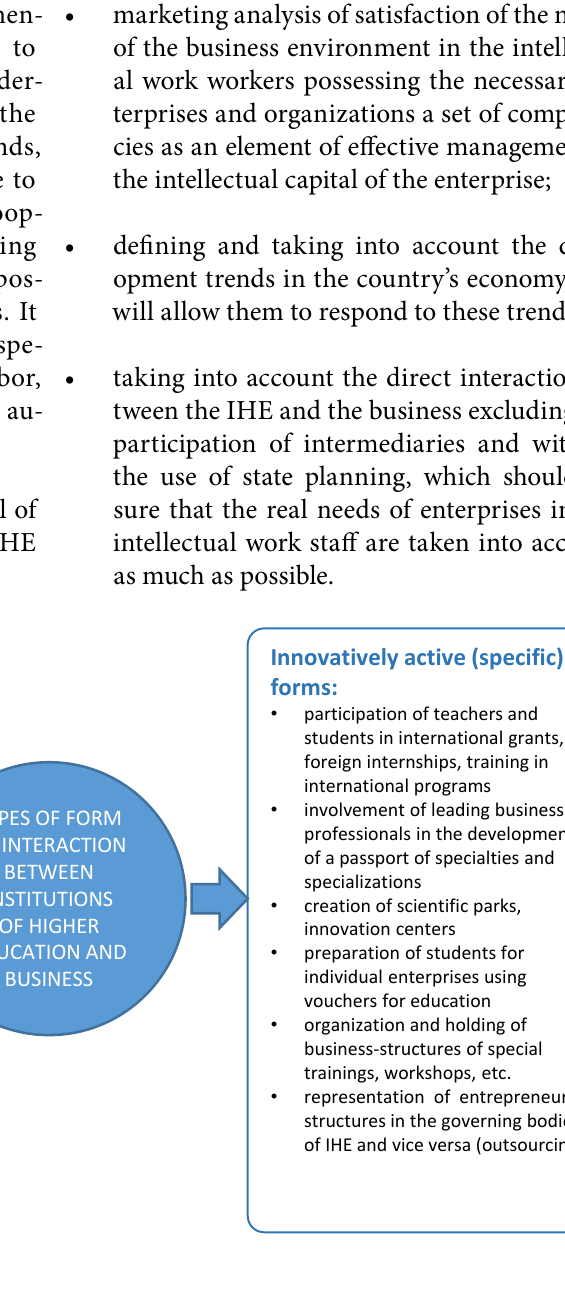
Figure 4. Types of standard and innovative